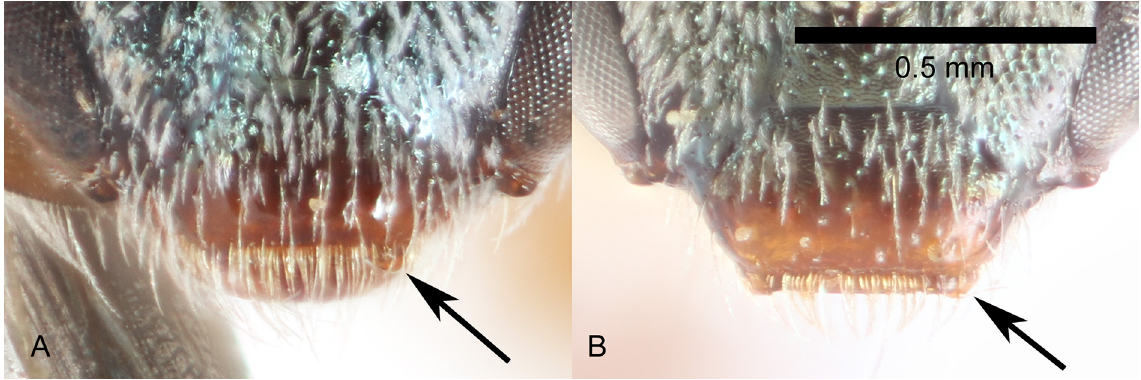
Fig. 3. Clypeus apicolateral denticles. A . Lasioglossum ( D. ) minckleyi sp. nov., acute points. B . L. ( D. ) arenisaltans sp. nov., low